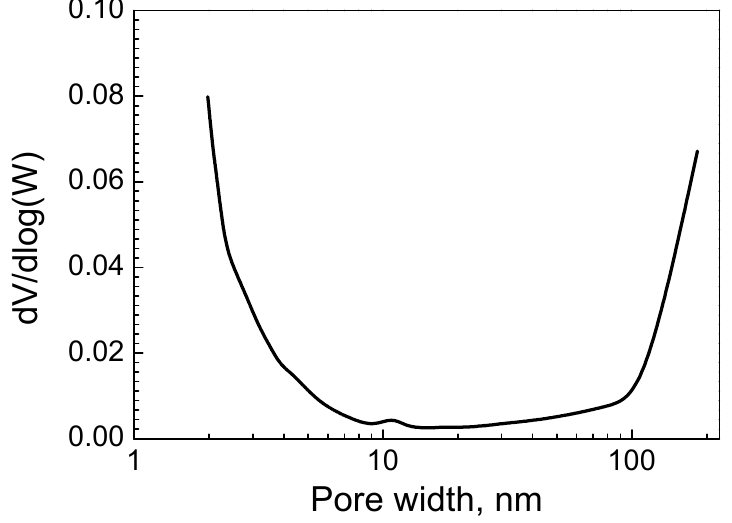
Figure 5. Pore width distribution of biochar.